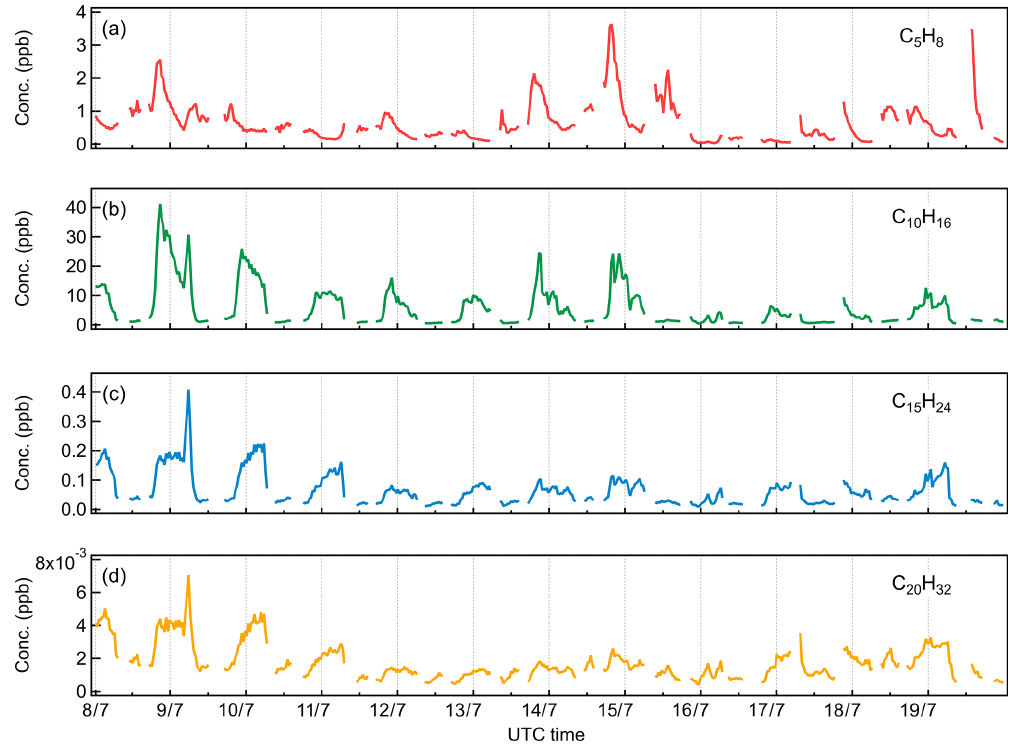
Figure 3. Time series of (a) C 5 H 8 , (b) C 10 H 16 , (c) C 15 H 24 , and (d) C 20 H 32